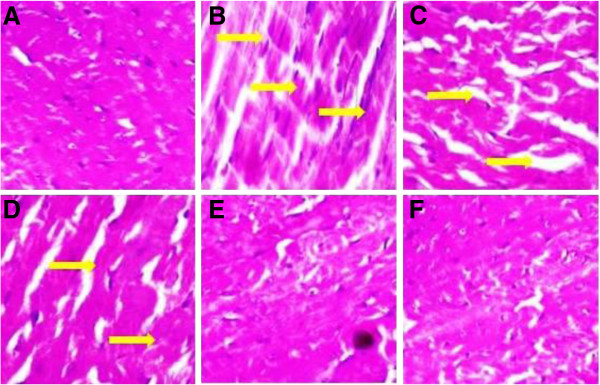
Effect of Melastoma malabathricum Linn. (MM) on heart in different groups of rats: (A) Normal control: Normal control group shown normal histopathology of the heart there is no changes in interstitial space and intercalated disc. (B) Diabetic control: Diabetic control histopathology shown increased interstitial space, deposition of fats and distort the intercalated disc (yellow arrow) (C) MM I (100 mg/kg): Tested drug histopathology shown decreased interstitial space and having slightly distort intercalated disc (yellow arrow) (D) MM II (250 mg/kg): Tested drug histopathology shown less effect of interstitial space and intercalated disc (yellow arrow) (E) MM III (500 mg/kg): Tested drug histopathology shown normal heart like the glibenclamide (F) Glibenclamide (10 mg/kg): Glibenclamide treated drug shown the normal histopathology of heart. The samples were obtained from the same liver anatomical regions. For each group, 6 rats were examined and 50 pictures were taken. The above picture for each group was chosen randomly from the 80 pictures in this group. Original magnification, 40 ×.